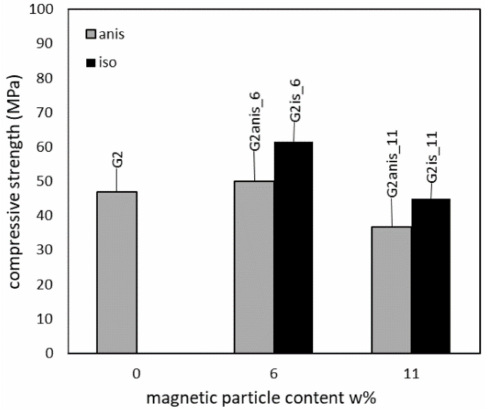
Figure 20. Compressive strength data for samples of series